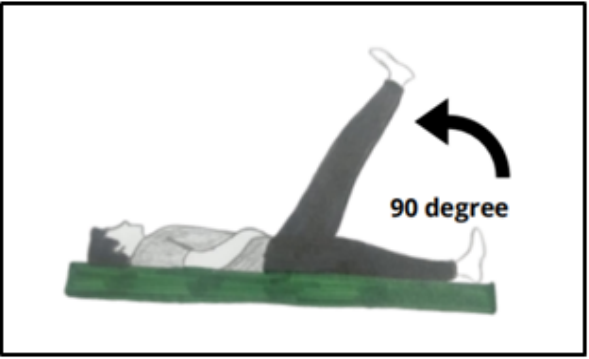
Figure-IX: Exhibition of leg lifting exercise. Hamstring Stretch: This exercise is the safest and